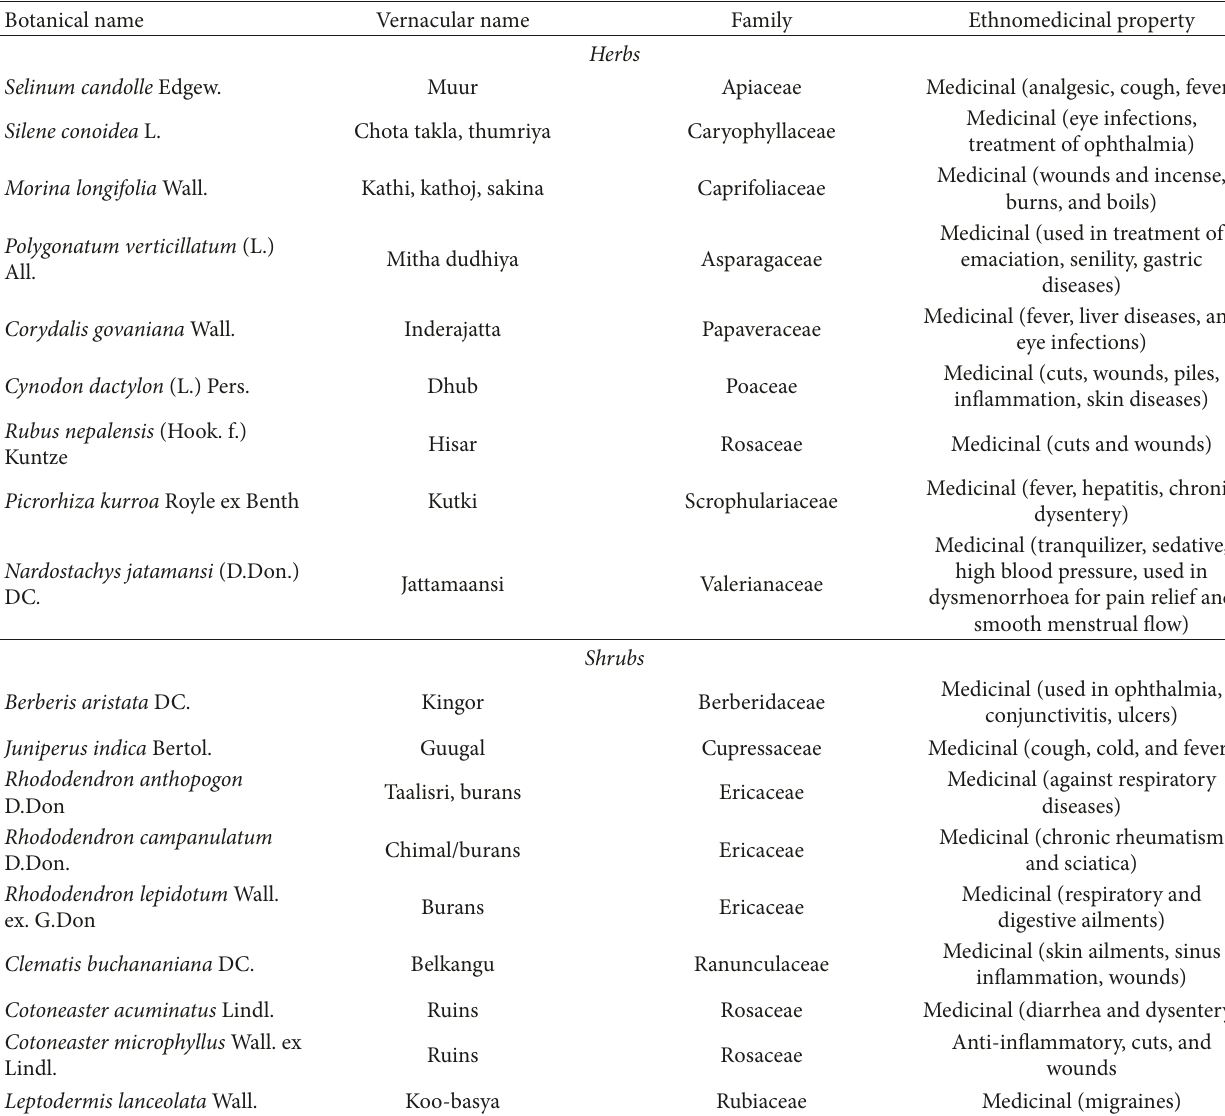
Table 8: List of Herbaceous and Shrub species (with ethnomedicinal properties) found in Tungnath